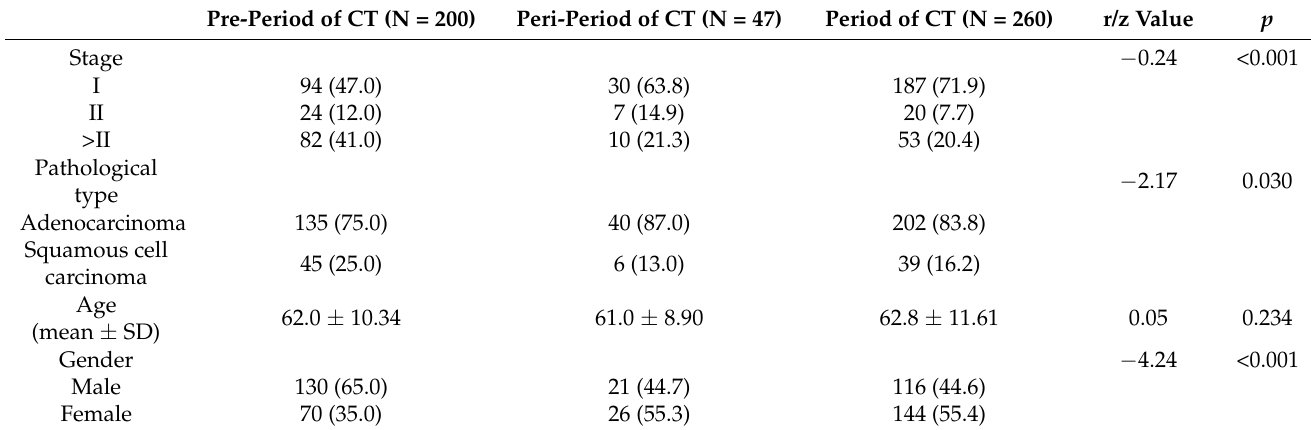
Table 1. Characteristics of lung cancer patients during pandemic of COVID-19.